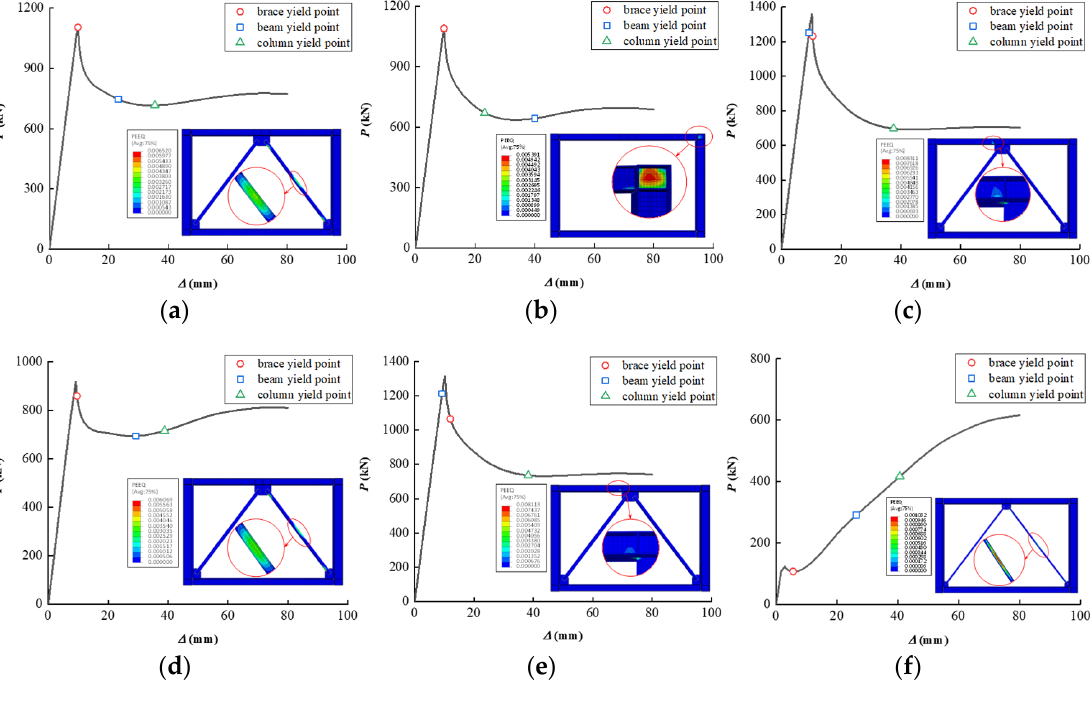
Figure A3. The predicted PEEQ distributions of top floor concentrically ‐ braced steel frames ( η = 0.3). ( a ) case 15, the basic model obtained by the proposed method; ( b ) case 18, with smaller column web section area; ( c ) case 20, thicker braces; ( d ) case 24, thinner braces than in the basic model; ( e ) case 27, larger external brace diameter; ( f ) case 30, smaller external brace diameter than in the basic model.